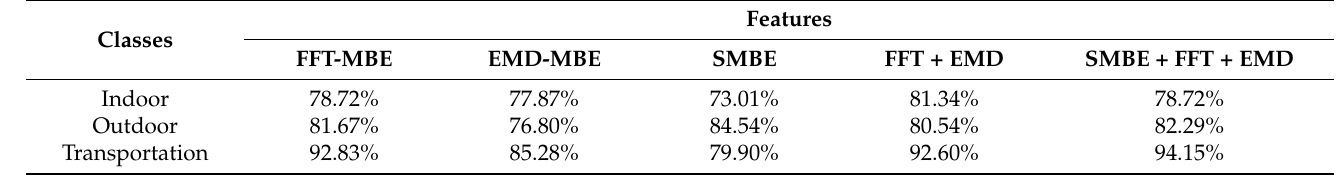
Table 4. Classification accuracy of each class for the Low Complexity ASC